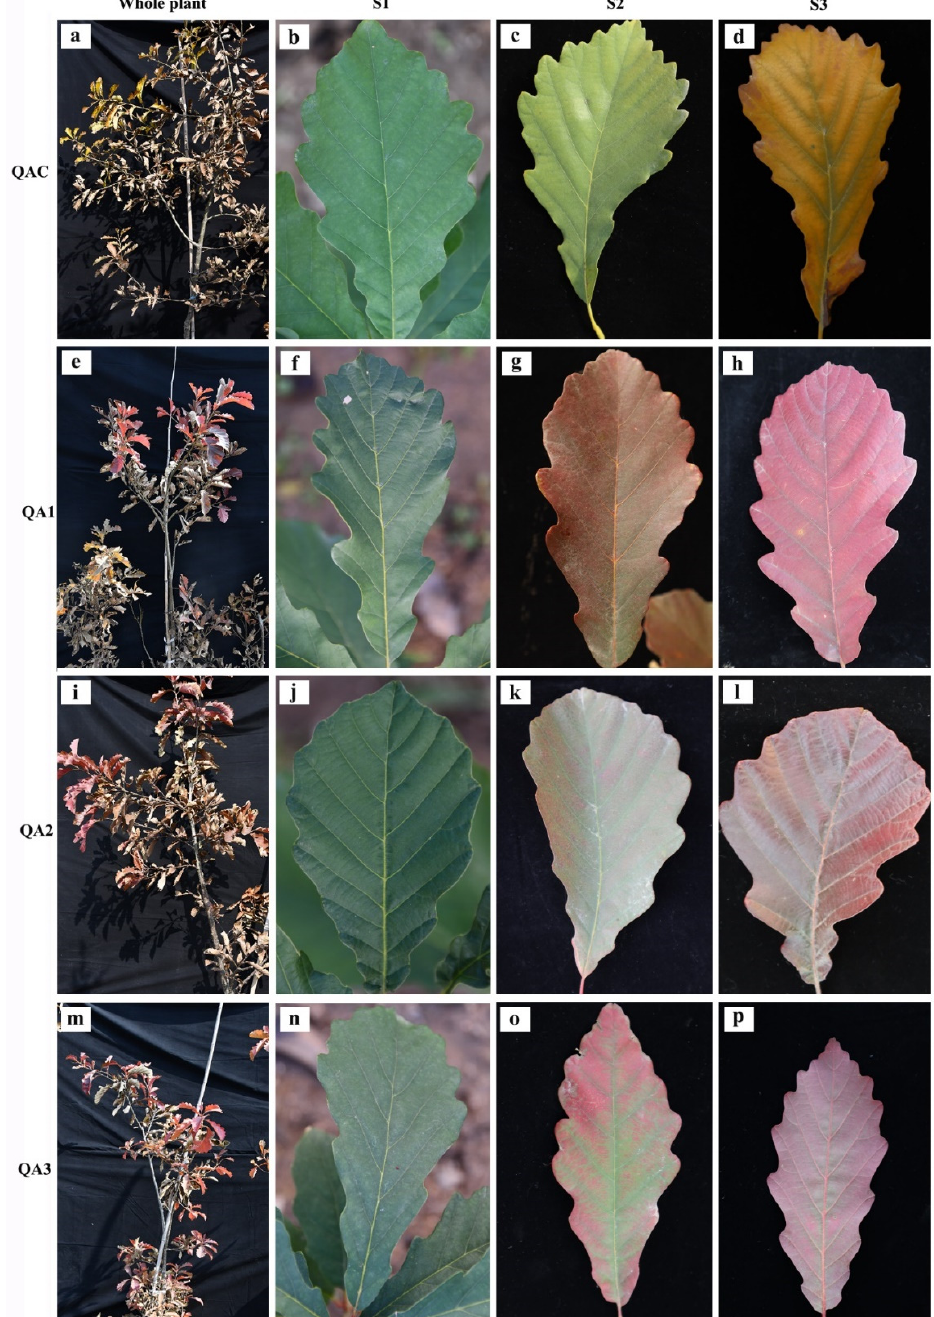
Figure 1. Representative images of whole plant and autumn leaf coloration in four Quercus aliena accessions. Whole plant images of QAC ( a ), QA1 ( e ), QA2 ( i ), and QA3 ( m ) at S3; green leaves of QAC ( b ), QA1 ( f ), QA2 ( j ), and QA3 ( n ) at S1; green-yellow leaves of QAC ( c ) at S2; green-red leaves of QA1 ( g ), QA2 ( k ), and QA3 ( o ) at S2; green-yellow leaves of QAC ( d ) at S3; and red leaves of QA1 ( h ), QA2 ( l ), and QA3 ( p ) at